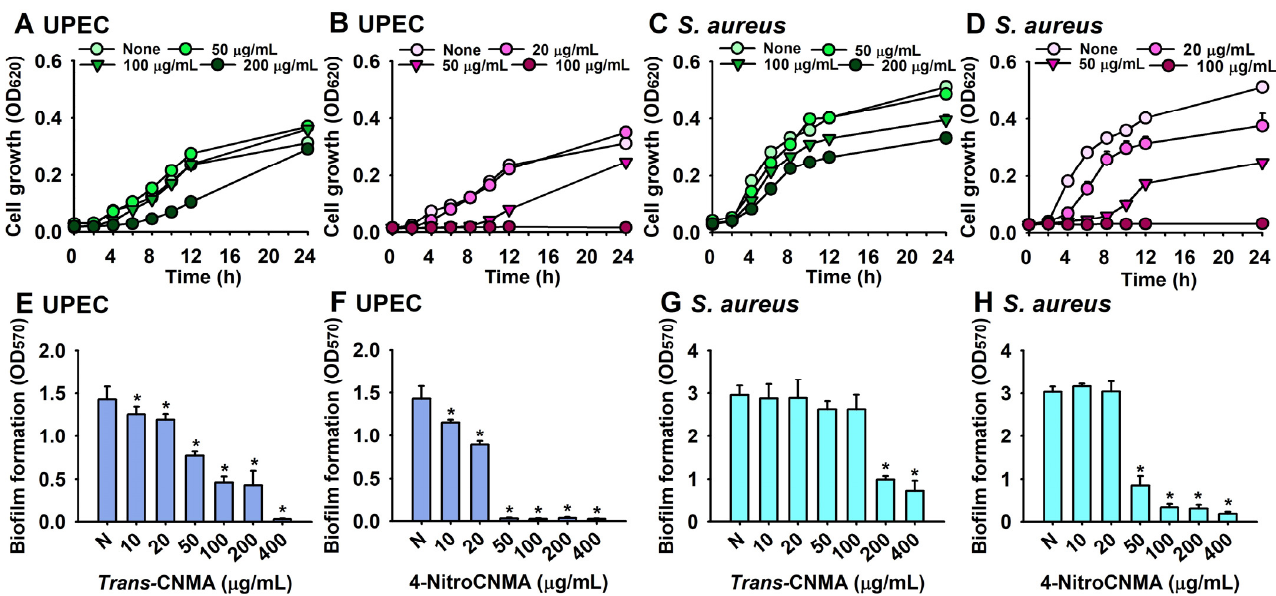
Figure 2. Planktonic cell growth in the presence of trans -CNMA or 4-nitroCNMA against UPEC in NB medium ( A , B ) and S. aureus in LB medium ( C , D ). Antibiofilm activities of trans -CNMA and 4-nitroCNMA against UPEC ( E , F ) and S. aureus ( G , H ). Error bars indicate standard deviations. * p < 0.05 vs. nontreated controls (None).